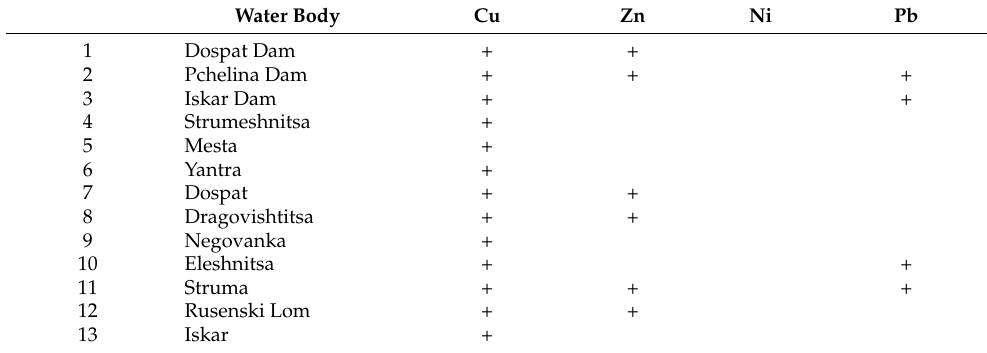
Table 2. The exceedances for Cu, Zn, Ni and Pb in the studied Bulgarian surface water